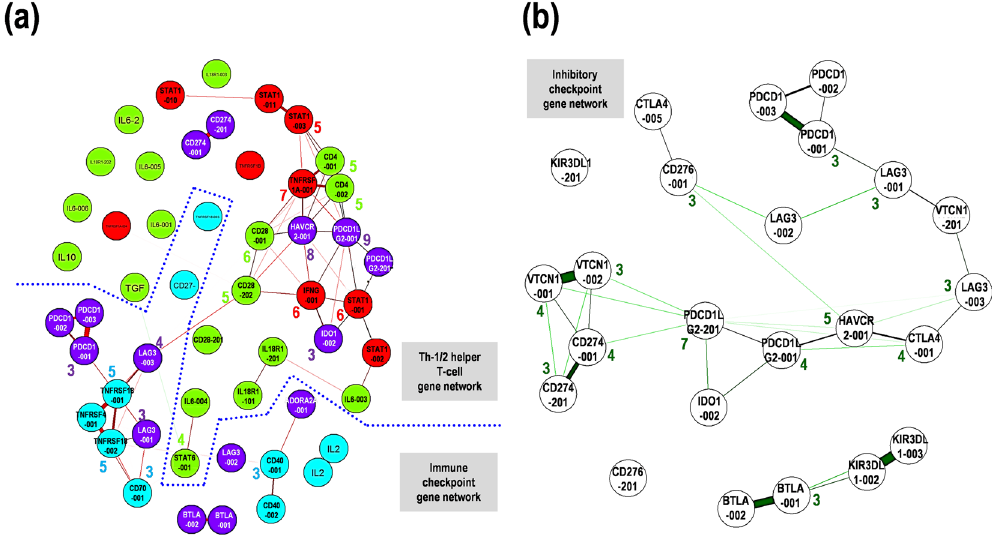
Figure 6. Schematic representation of the correlation between the gene expression in the T helper cell type 1/2 (Th-1/Th-2) status and immune checkpoint in primary central nervous system lymphoma (PCNSL). ( a ) Correlation among Th-1 (red) and Th-2 (green), stimulatory checkpoint (blue), and inhibitory checkpoint (purple). ( b ) Correlation among inhibitory checkpoint molecules. Thick and thin lines with a distance indicate strong and weak correlation between the expression levels of the two genes. The numbers with circles indicate the numbers of nodes over